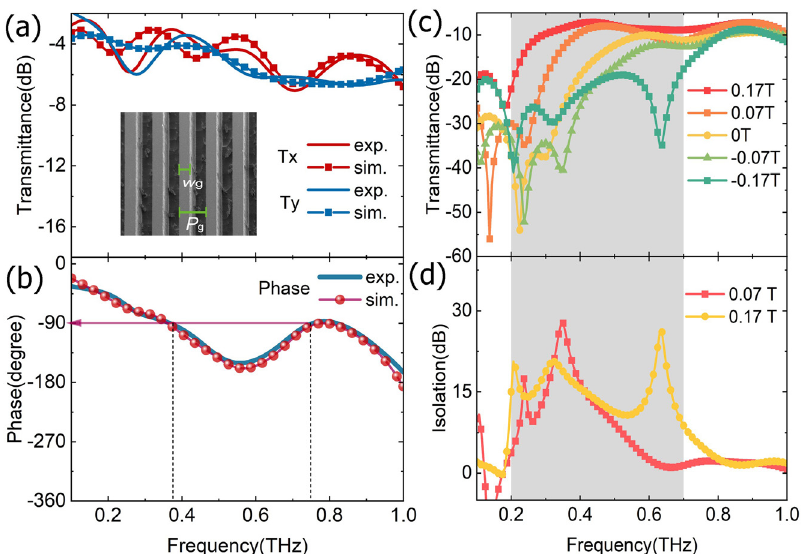
Figure 5: The simulative and experimental transmission spectra of the meta-grating without the InSb for x -LP (along with the minor axis) and y -LP (along with the long axis of grating); the parameters of the structure are as follows: the grating period P g = 200 μ m, the width of the Si bar is W g = 75 μ m and the etching depth of the grating is 200 μ m. (b) The simulative and grating between two orthogonal x -LP and y - LP. (c) The experimental transmission spectra from LP input to LP output of the GIG under different MFs; (d) isolation of the GIG under different